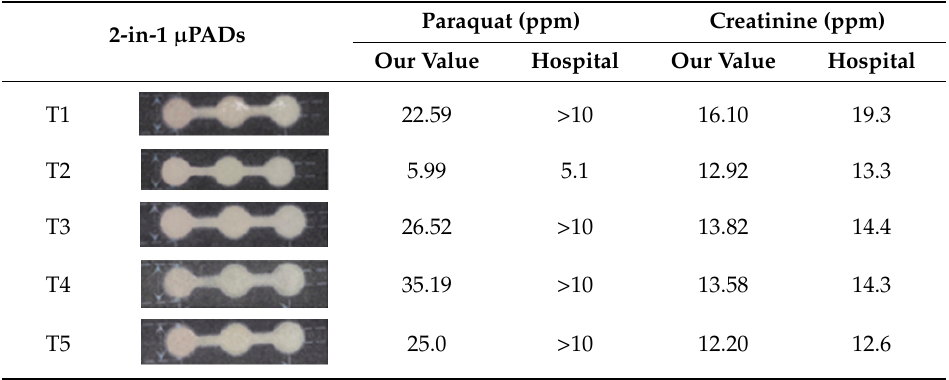
Table 2. Clinical data of patients with PQ intoxication (n = 5).